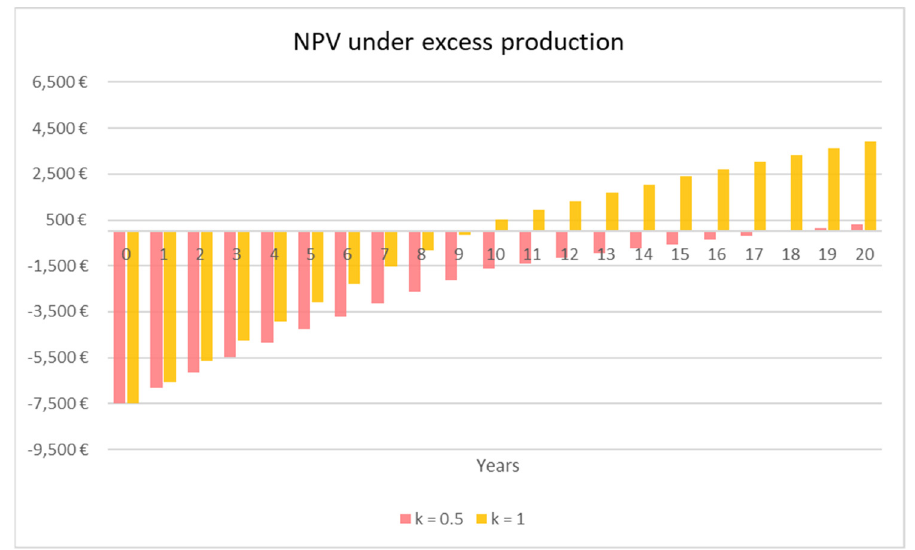
Figure 5. Applicant NPV obtained when EC experiences excess of production.